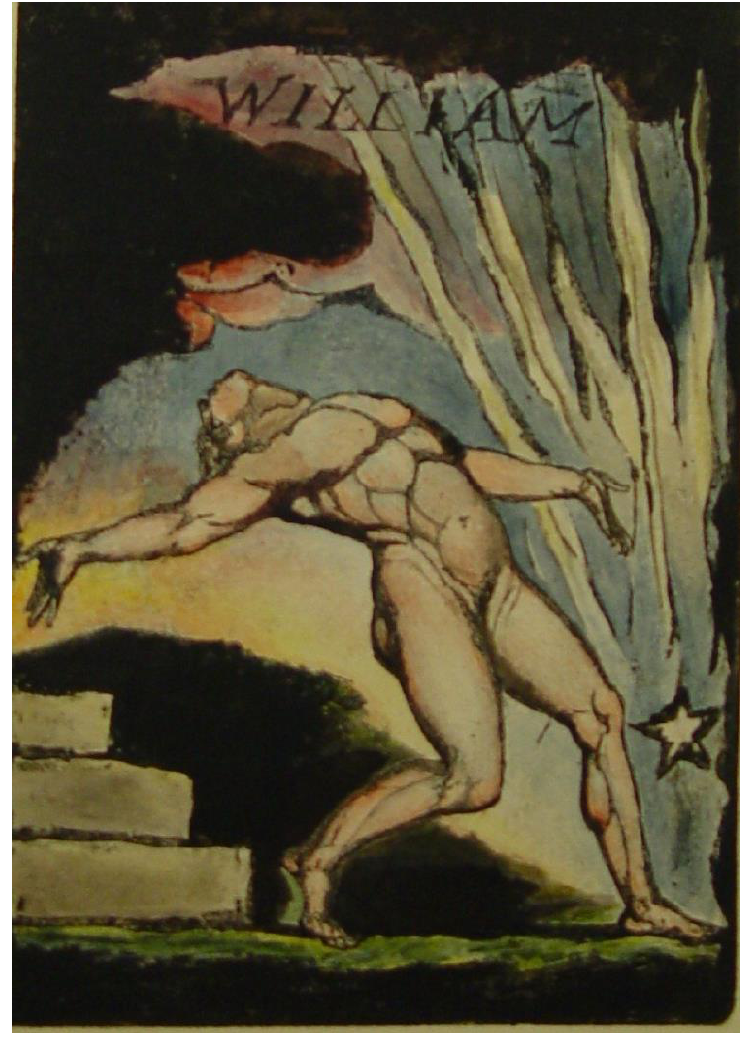
Figure 2. Milton: A Poem , Copy A, Plate 29 © The Trustees of the British Museum.